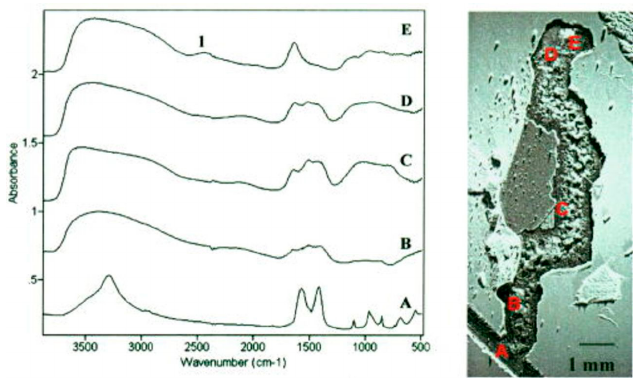
Figure 8. IR spectra obtained at the head and tail of the filiform corrosion products of the aluminum alloy AA6016 pretreated with Ti-Zr and covered with paint, exposed to 85% RH for six weeks [68]. Reproduced from reference [68] by permission of The Electrochemical Society. Copyright 2002.